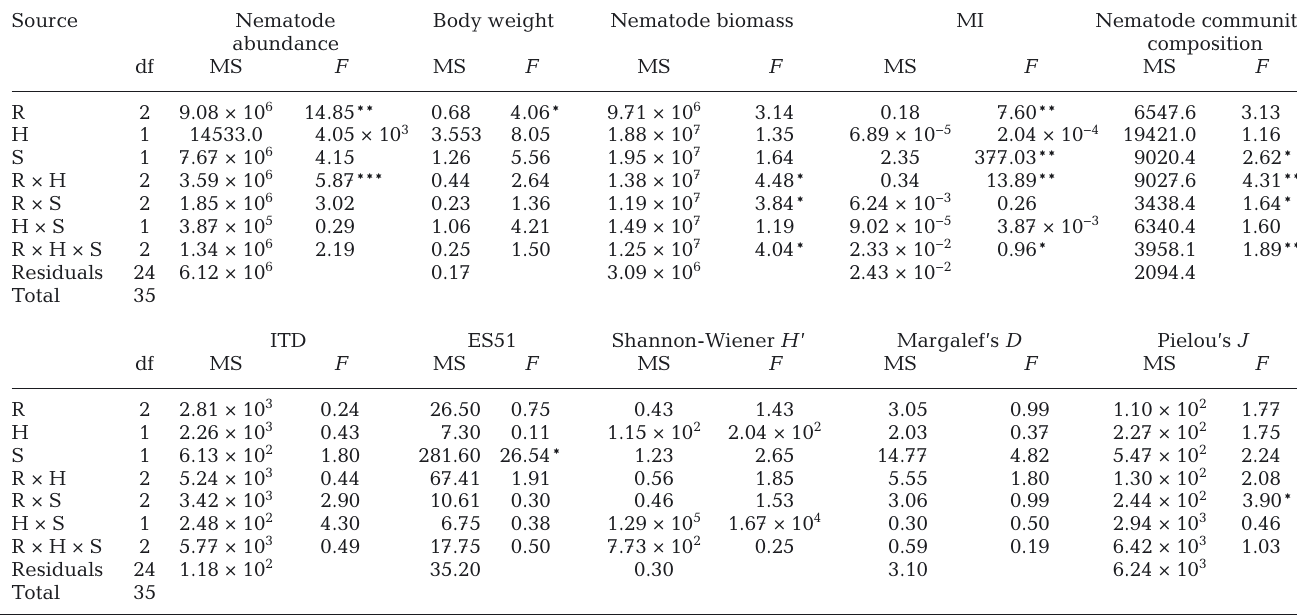
Nematode Body weight Nematode biomass MI Nematode community abundance composition df F